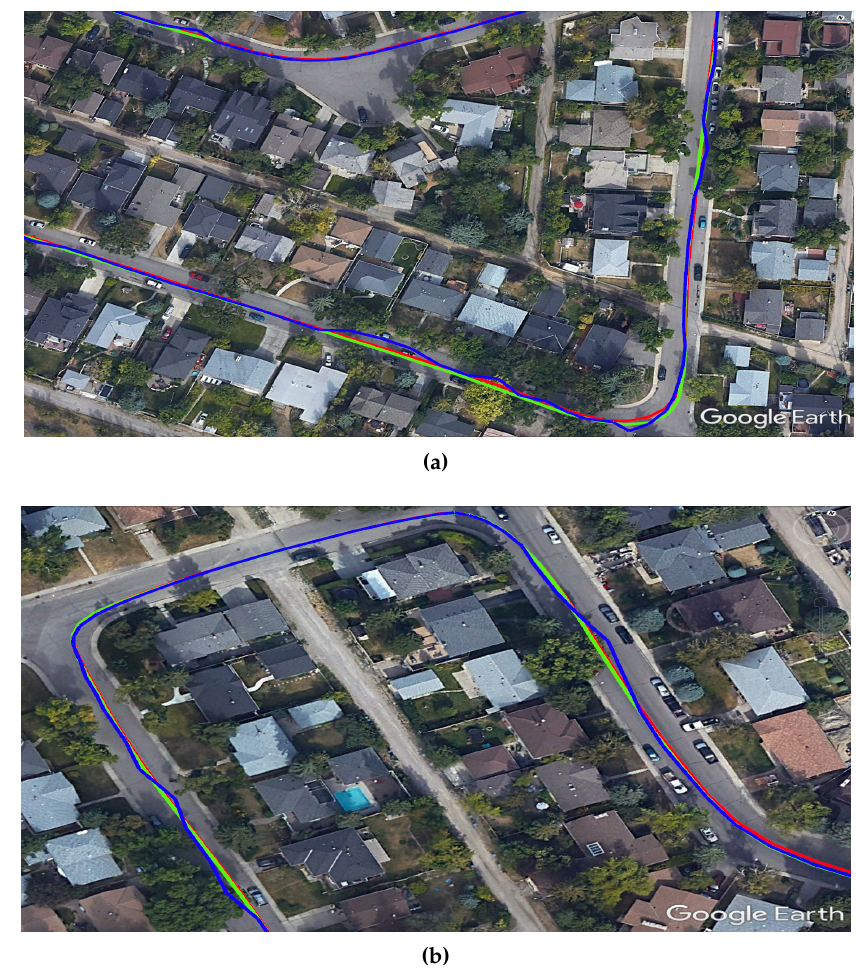
Figure 7. Two examples ( a ) and ( b ) of the developed SF-PPP/INS system performance in suburban areas showing how the system can provide a solution within the driving lane. The three displayed solutions are: reference (red), SF-PPP (blue), and integrated SF-PPP/INS